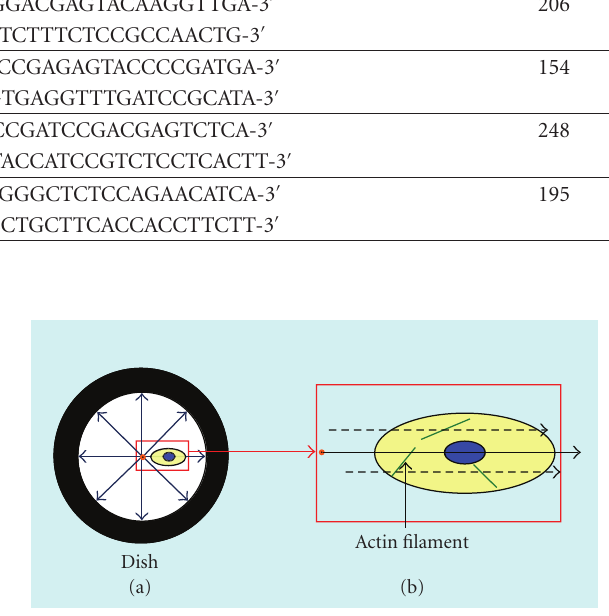
Figure 2: Stretching force is loaded equally by stretching machine (a). Stretching line was drawn from center point to the periphery of the culture dish through the center of cell nucleus in both groups. The angle made by this line and each of the actin filament in the cytoplasm on the Immunofluorescence picture was measured (b).